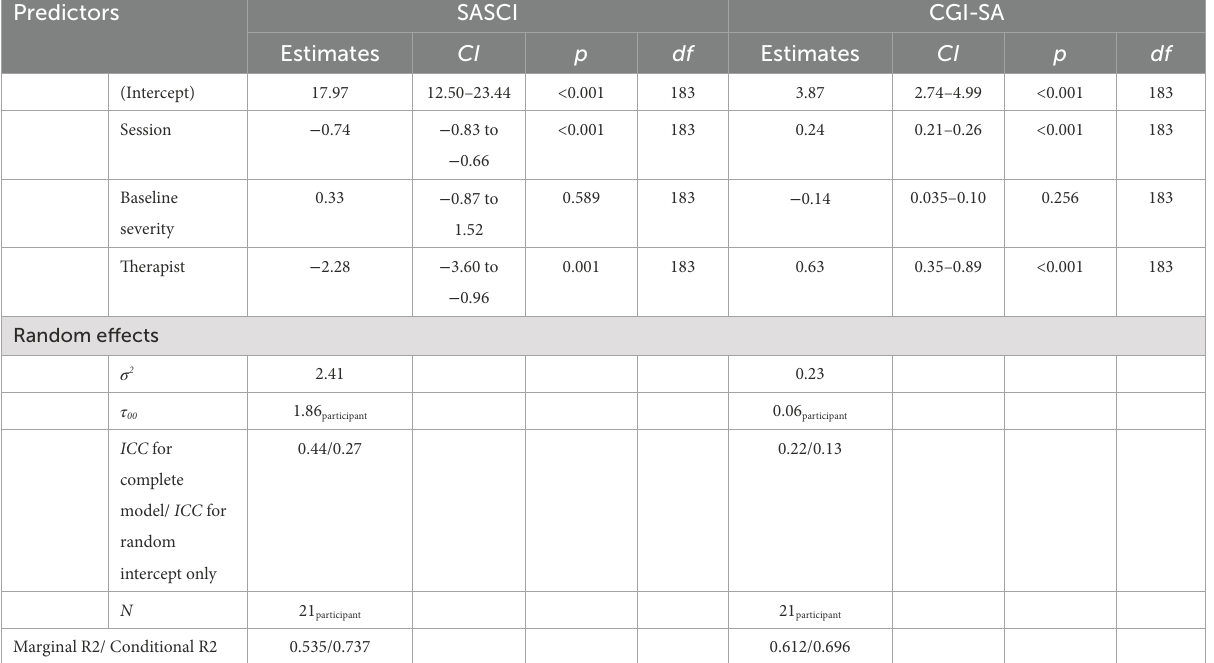
TABLE 2 Linear mixed model for session and therapist as fixed-effects explaining self and therapist-reported symptom change while adjusting for baseline severity. Predictors